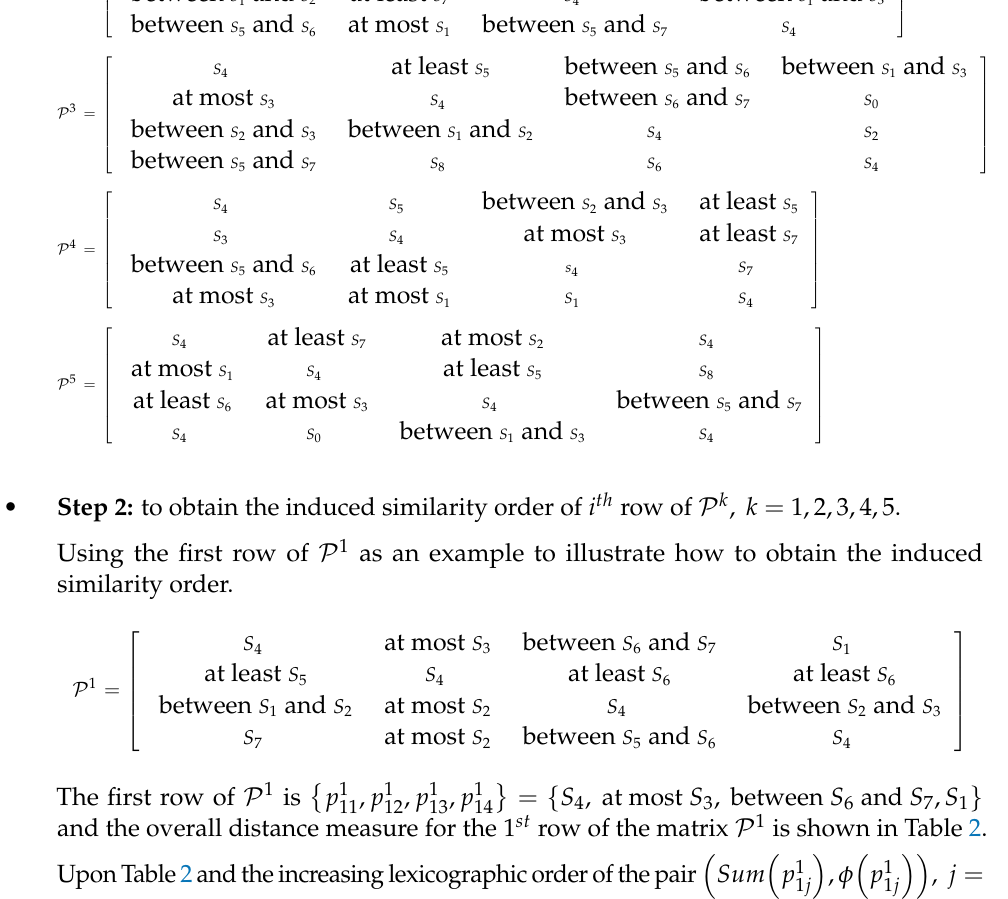
The first row of P 1 is Upon Table 2 and the increasing lexicographic order of the pair 1, 2, 3, 4 , we obtain Sum (cid:0) (cid:1) = p 1 φ 11